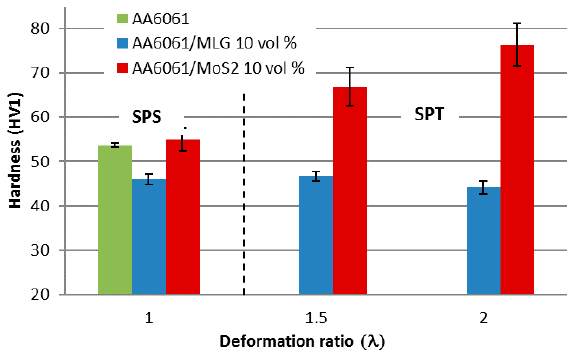
Figure 6. Influence of SPS and SPT processing conditions on the hardness of AA6061 matrix composites.